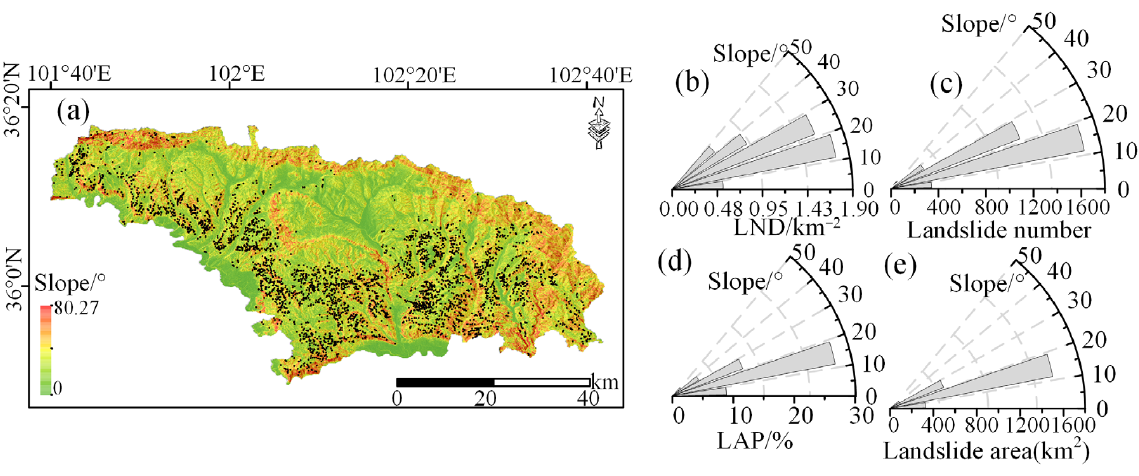
Figure 9. Relationship between slope and landslide distribution. ( a ) Slope distribution in the study area. ( b – e ) Statistics of landslide indicators in the slope intervals.